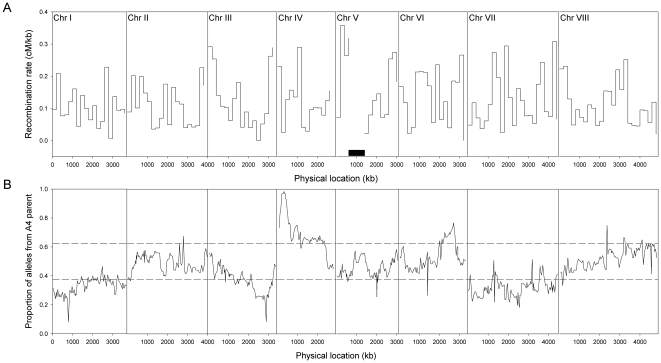
Recombination rate and segregation ratios throughout the genome.(A) Variation in recombination rate averaged over non-overlapping 200 kb windows across Chromosomes I–VIII. Recombination rate is not displayed for the potential inversion on Chromosome V, which is denoted by the black rectangle. (B) Marker segregation ratios across Chromosomes I–VIII. The 95% confidence interval for a 1∶1 ratio is indicated by horizontal dashed lines at 0.375 and 0.625.